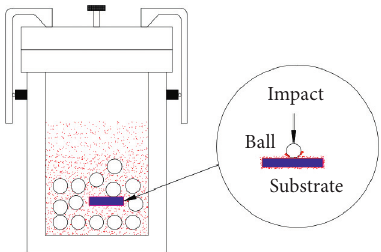
Figure 8: Schematic diagram of mechanical alloying method